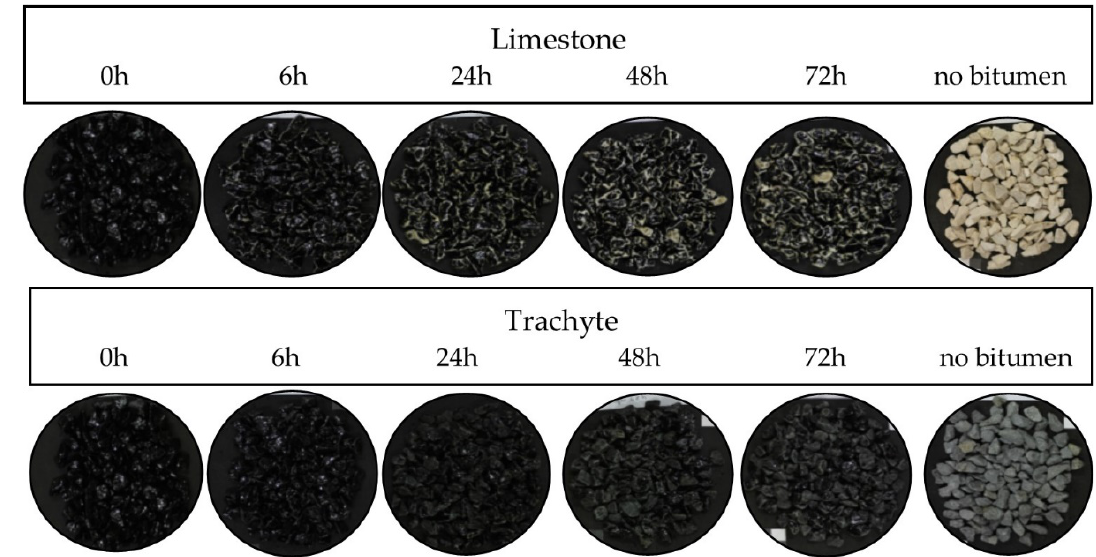
Figure 3. Samples obtained after each rolling-bottle time step for limestone and trachytic aggregates.